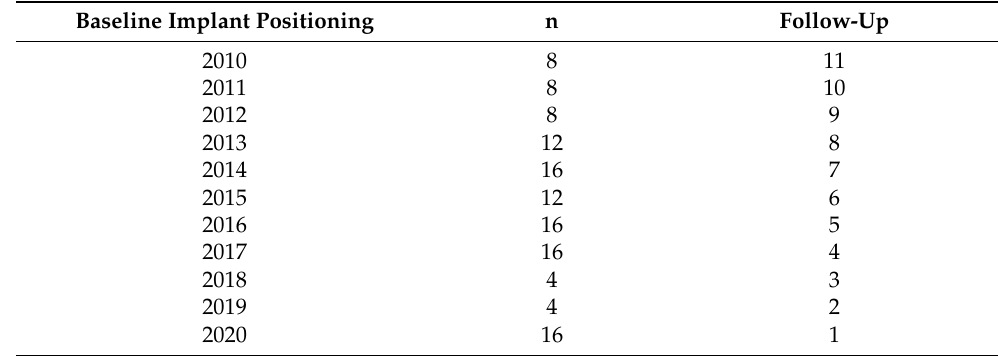
Table 2. Life table analysis at the implant level (n = implants placed per year; follow-up in years). Baseline Implant Positioning n Follow-Up